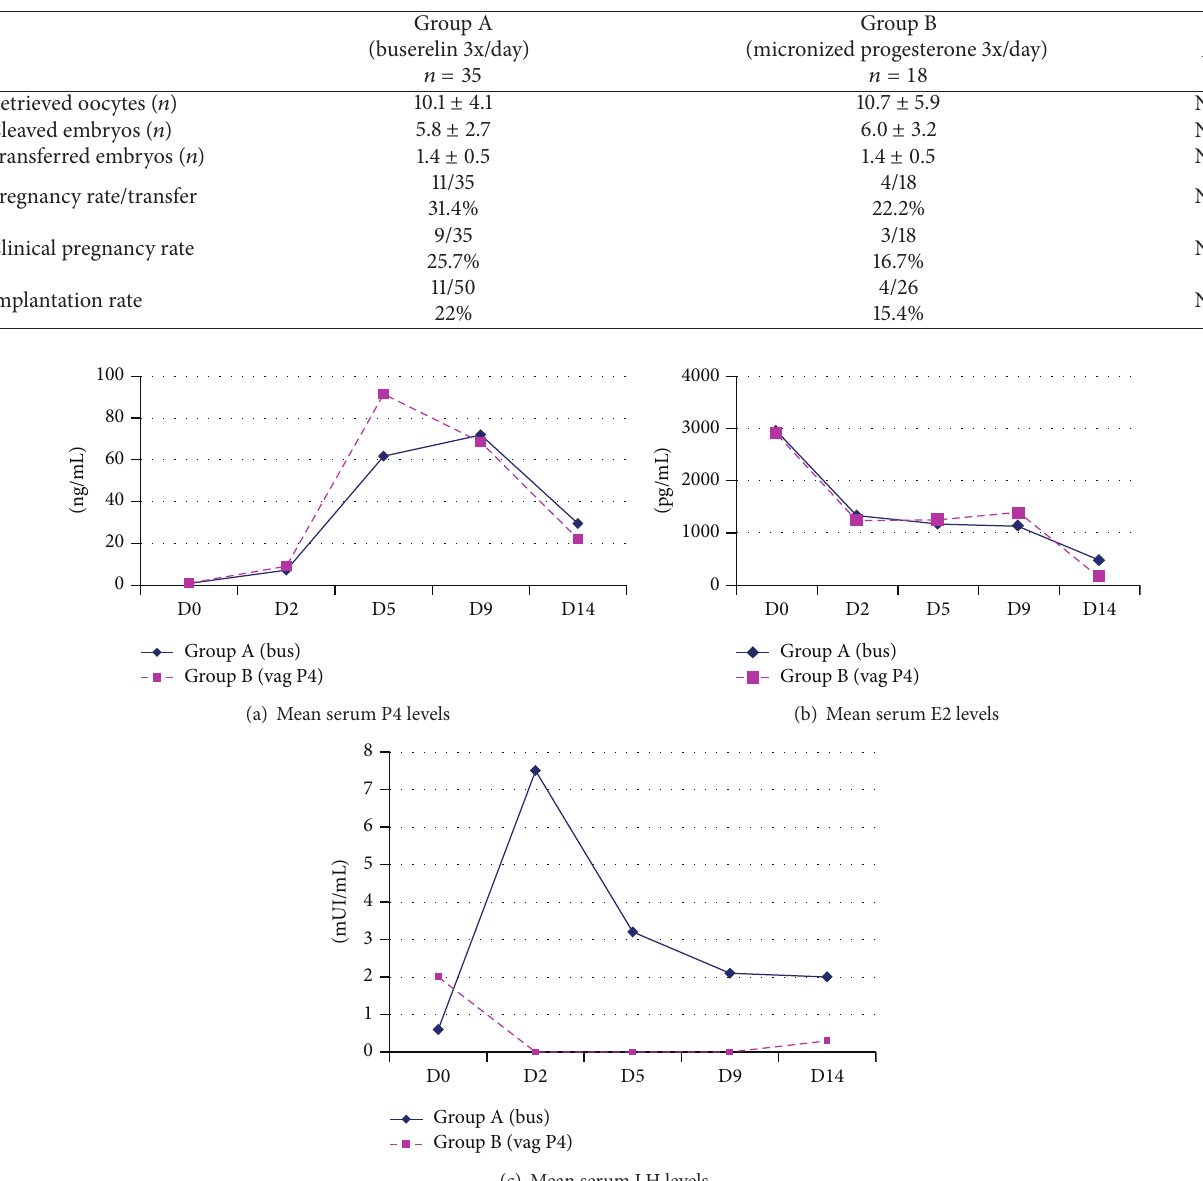
Table 2: IVF/ICSI cycle outcomes (mean ± SD).